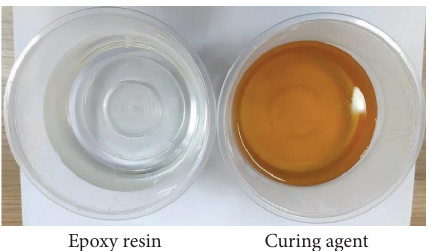
Figure 2: Epoxy resin and curing